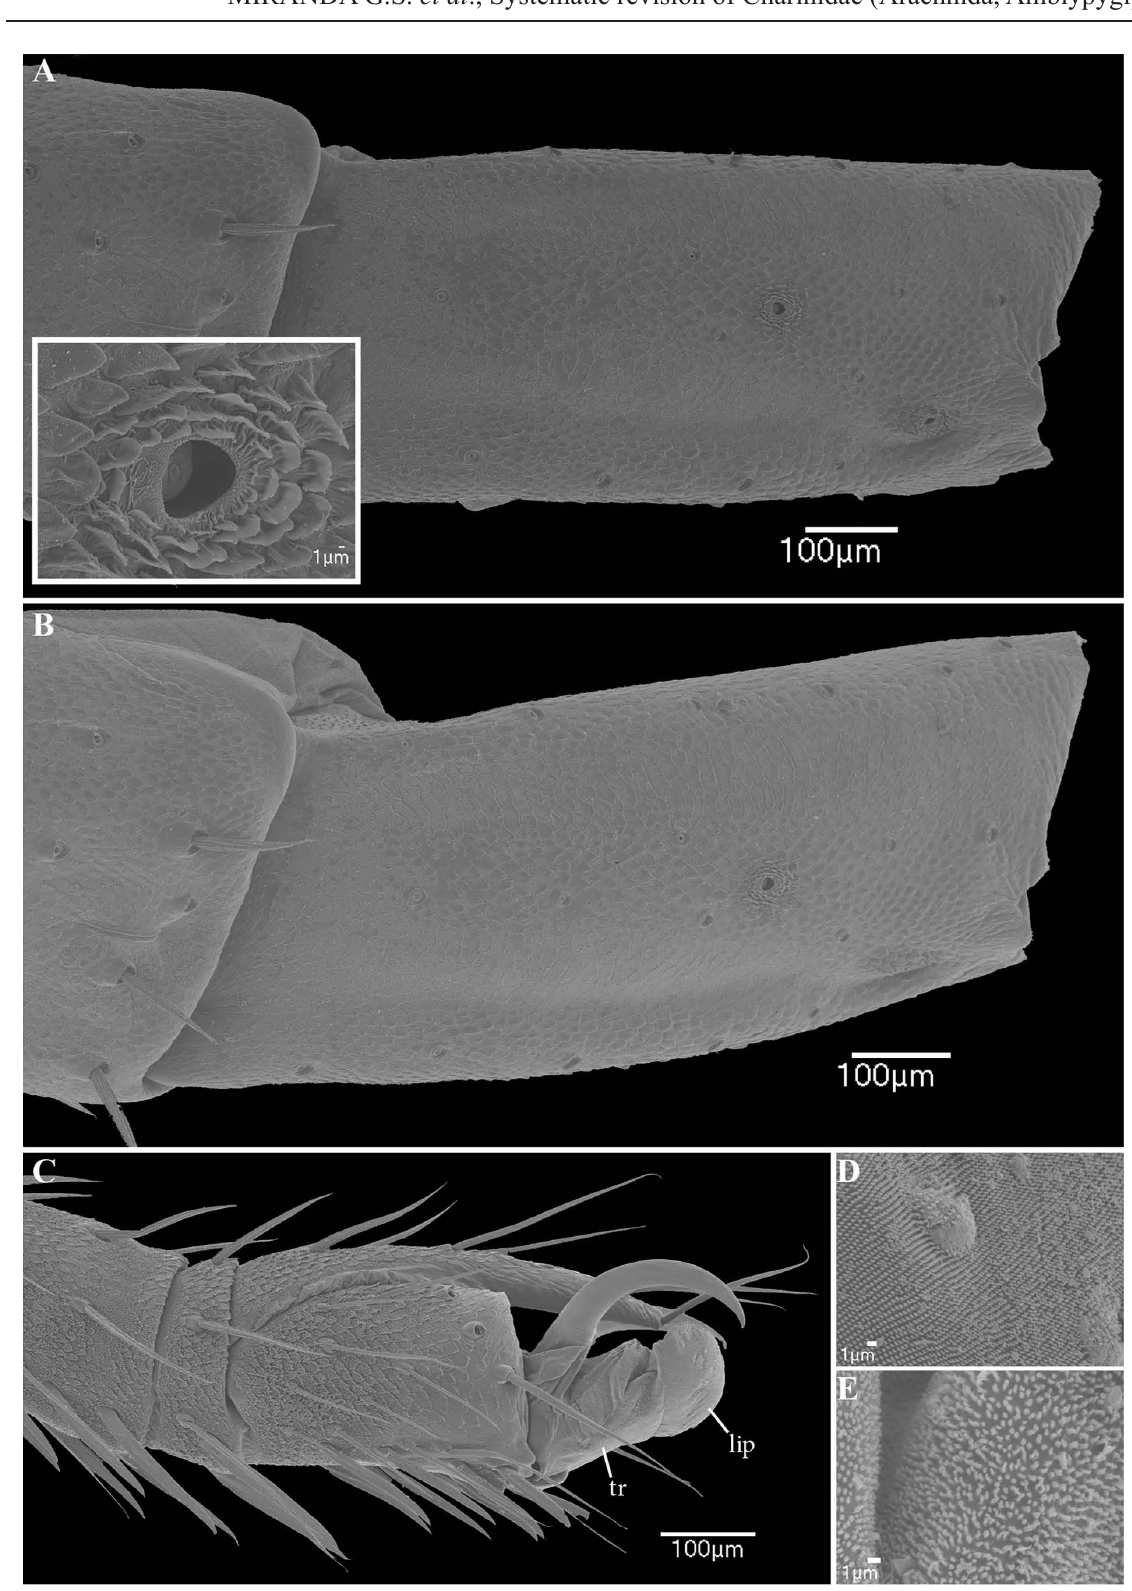
Fig. 41. Charinus insularis Banks, 1902 (RBINS), leg IV. A . Patella, dorsal view showing trichobothrial insertion. B . Patella, lateral view. C . Tarsus, lateral view. D . Aroliar lip. E . Aroliar truncus. Abbreviations: lip = aroliar lip; tr